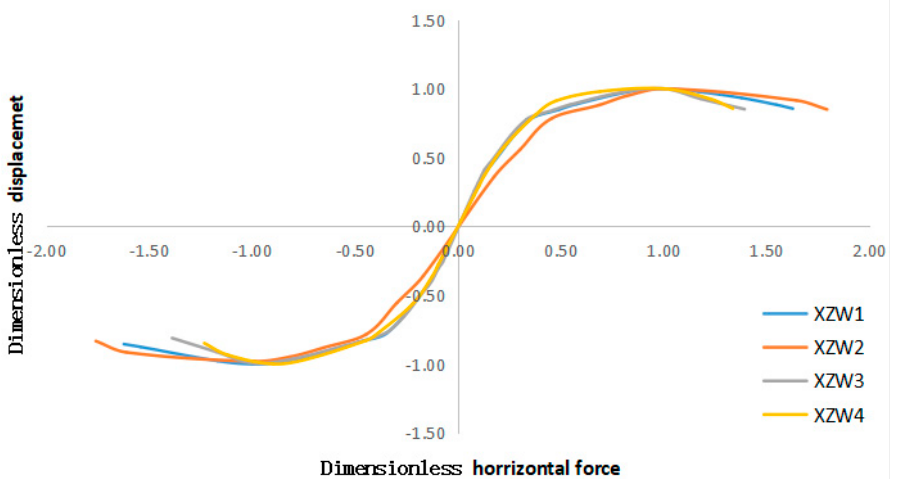
Figure 8. Dimensionless skeleton curves (loads are normalized by the maximum